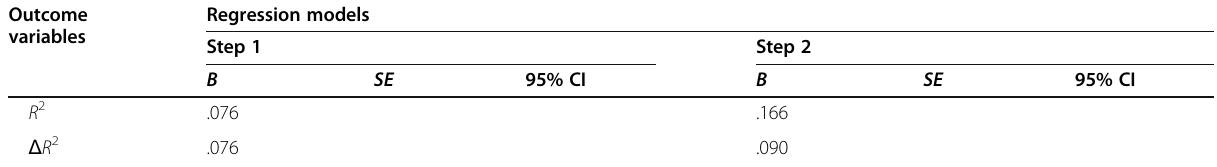
Table 3 Multiple regressions with covariates and CM predicting PTSD, depressive symptoms, resilience, and life satisfaction (Continued)